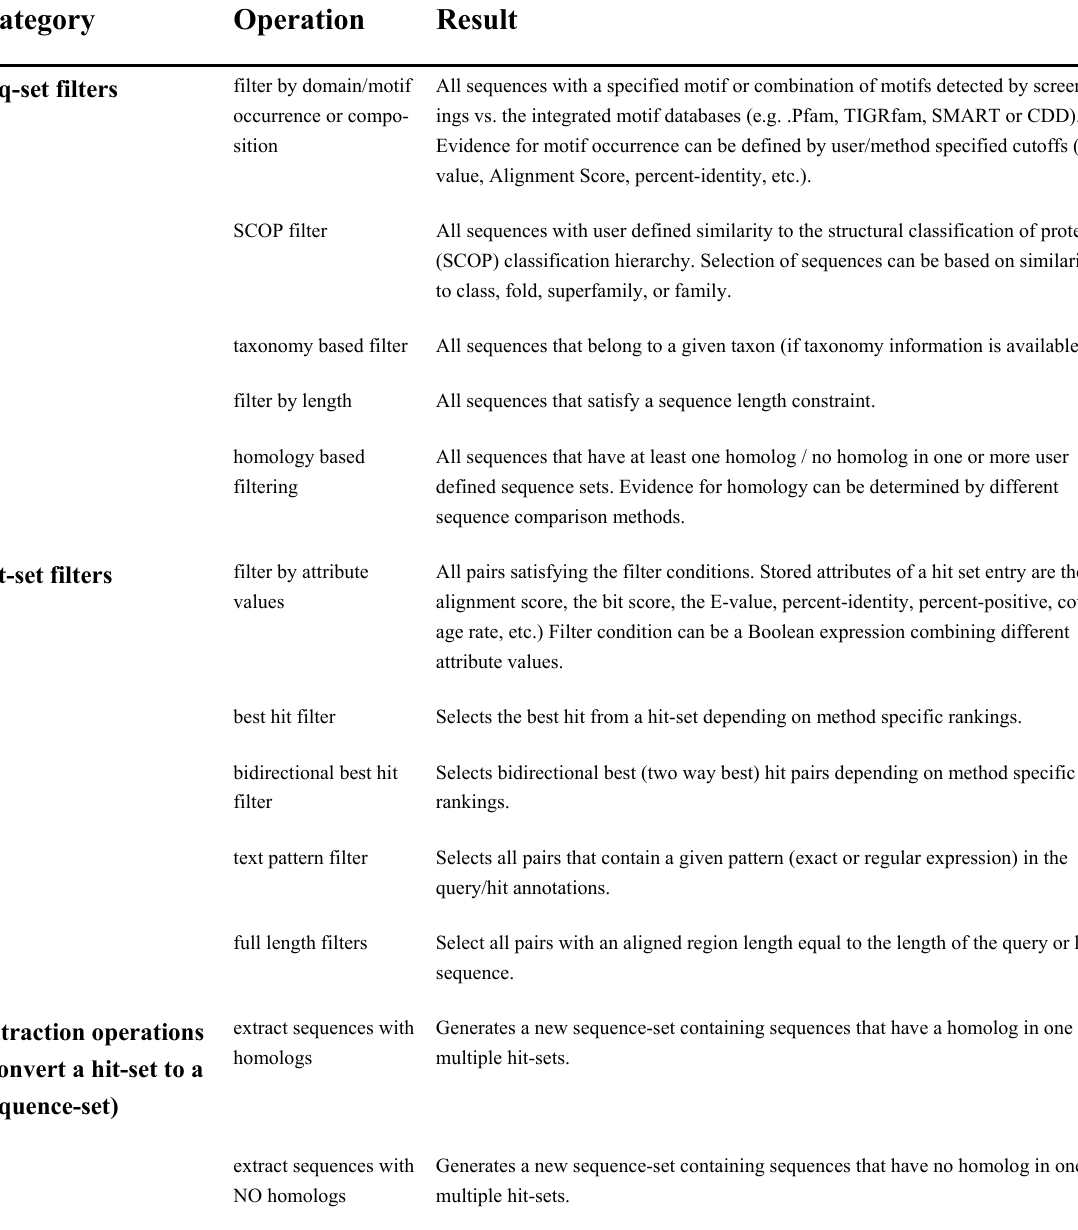
Table 1: An excerpt of available operations on seq-sets and hit-sets